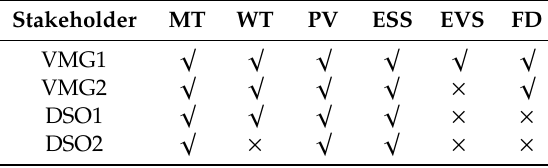
Table 1. Time-sharing electrovalence.